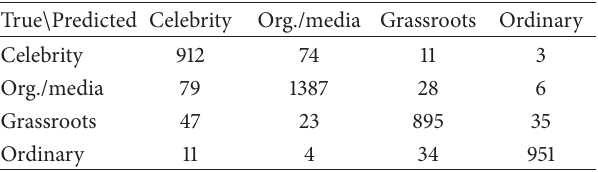
Table 2: Confusion matrix on 5-fold cross-validation.